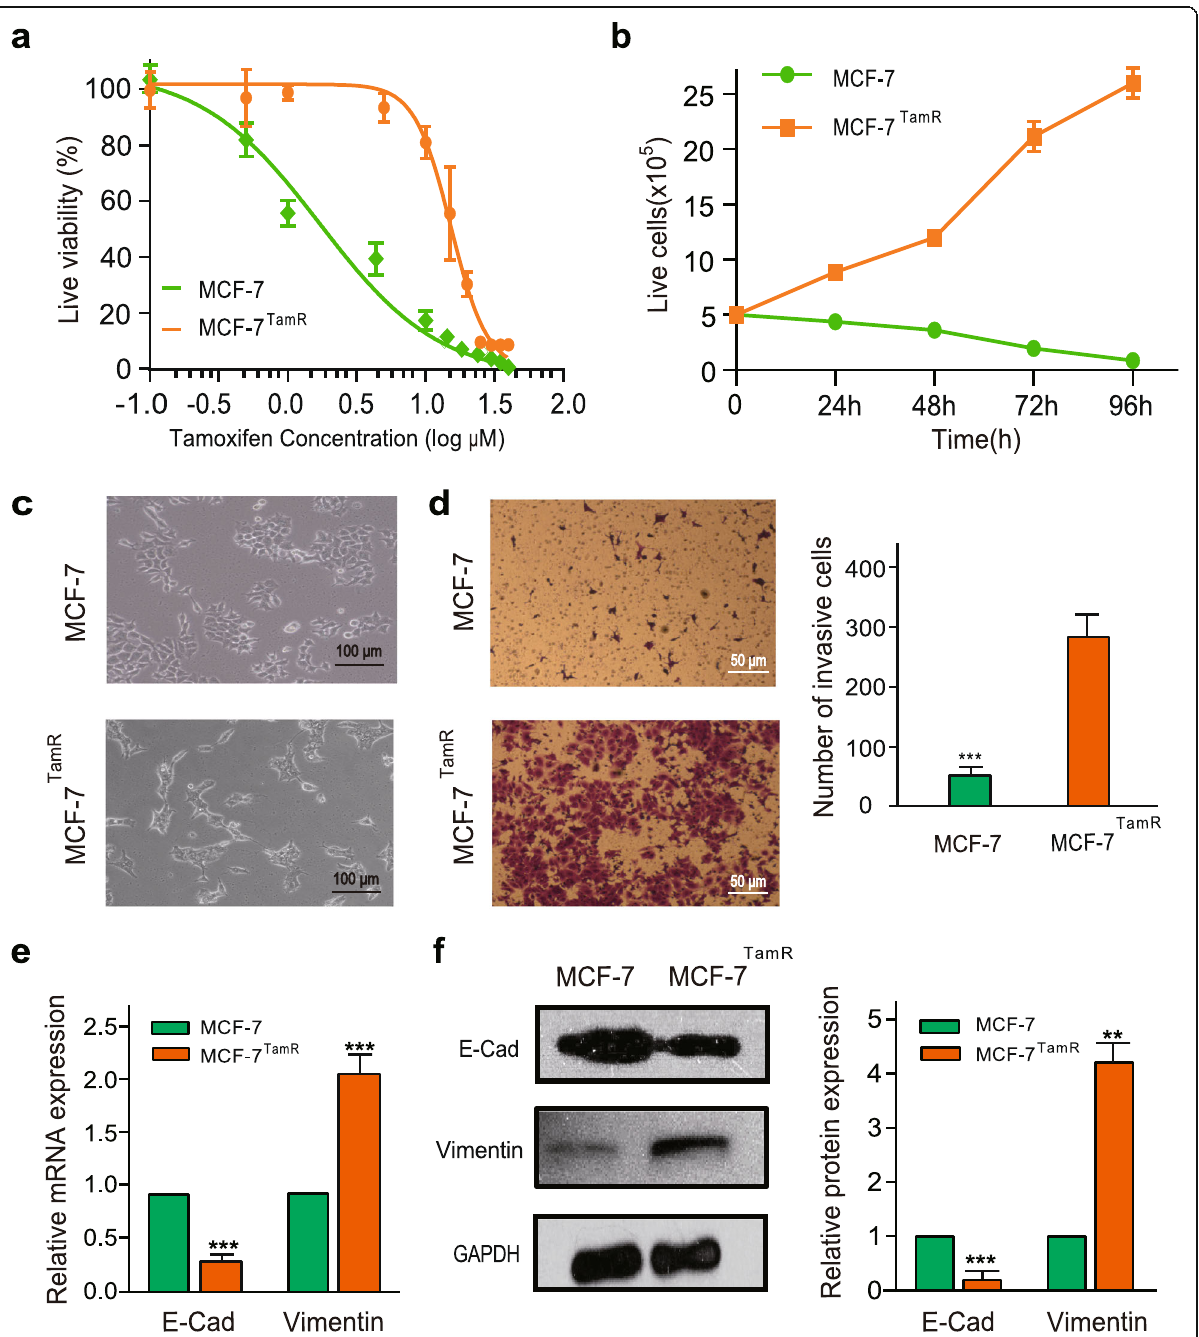
Fig. 1 Characterization of tamoxifen-resistant MCF-7 cells. a The growth inhibition curves of MCF-7 and MCF-7 TamR cells were obtained using the CCK-8 assay following the treatment of 4-hydroxytamoxifen (0 – 40 μ M) for 72 h. b The number of live cell of MCF-7 and MCF-7 TamR cells was counted during 15 μ M 4-hydroxytamoxifen treatment for 4 days. c Morphology of MCF-7 and MCF-7 TamR cells. d MCF-7 and MCF-7 TamR cell invasion was determined by the transwell assay (left, morphological comparison of cell penetration; right, quantitative bar graph for the number of migrating cells). Cells were counted in five random fields. Data are presented as the mean ± SD ( n = 3). *** p < 0.001. e The mRNA expression of E-cadherin and Vimentin were determined in MCF-7 and MCF-7 TamR cells by qRT-PCR. Data are presented as the mean ± SD ( n = 3). *** p < 0.001. f Western blotting for E-cadherin, Vimentin, and GAPDH in MCF-7 and MCF-7 TamR cells (left, representative images; right, quantitative bar graph for band density). ** p < 0.01, *** p <